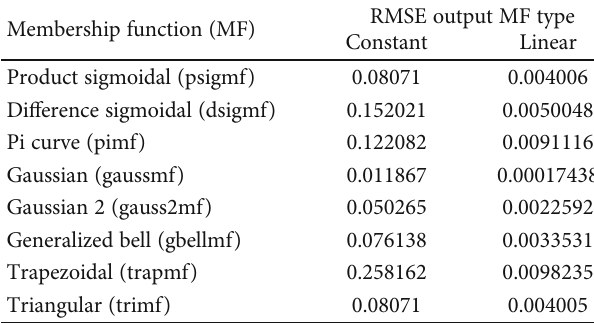
eff ) on the performance of the gas-turbine. Table 1: Training error of di ff erent